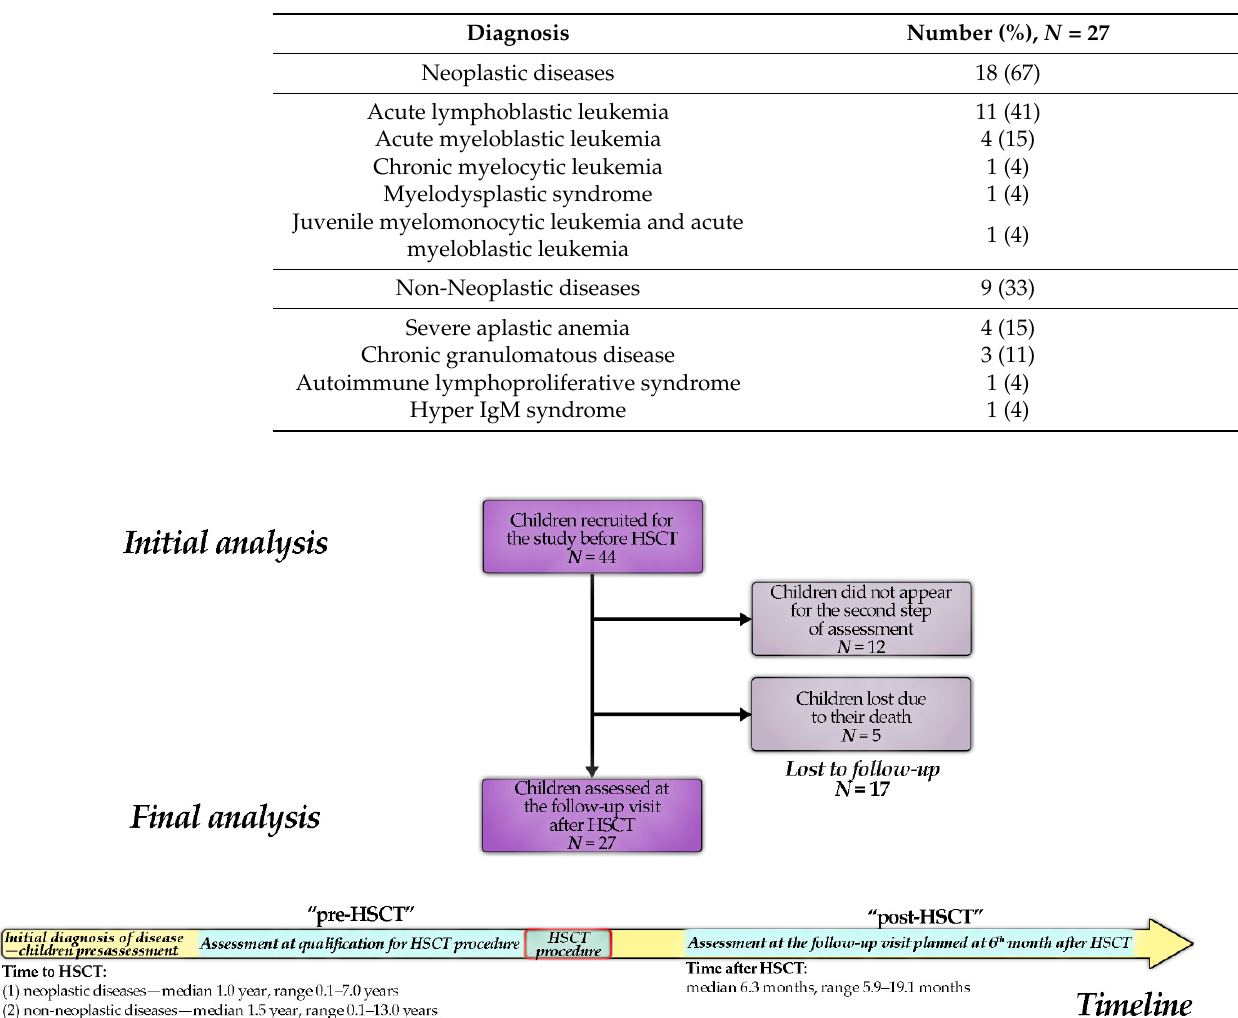
Figure 1. The study flowchart. The time range of each assessment step is shown.